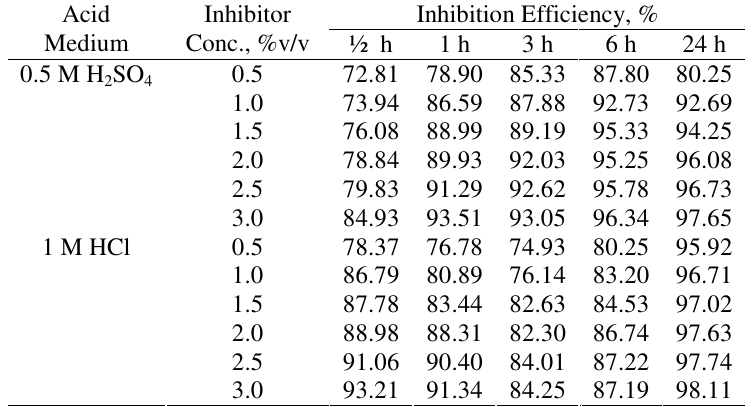
Table 2. Inhibition efficiency as a function of immersion time and